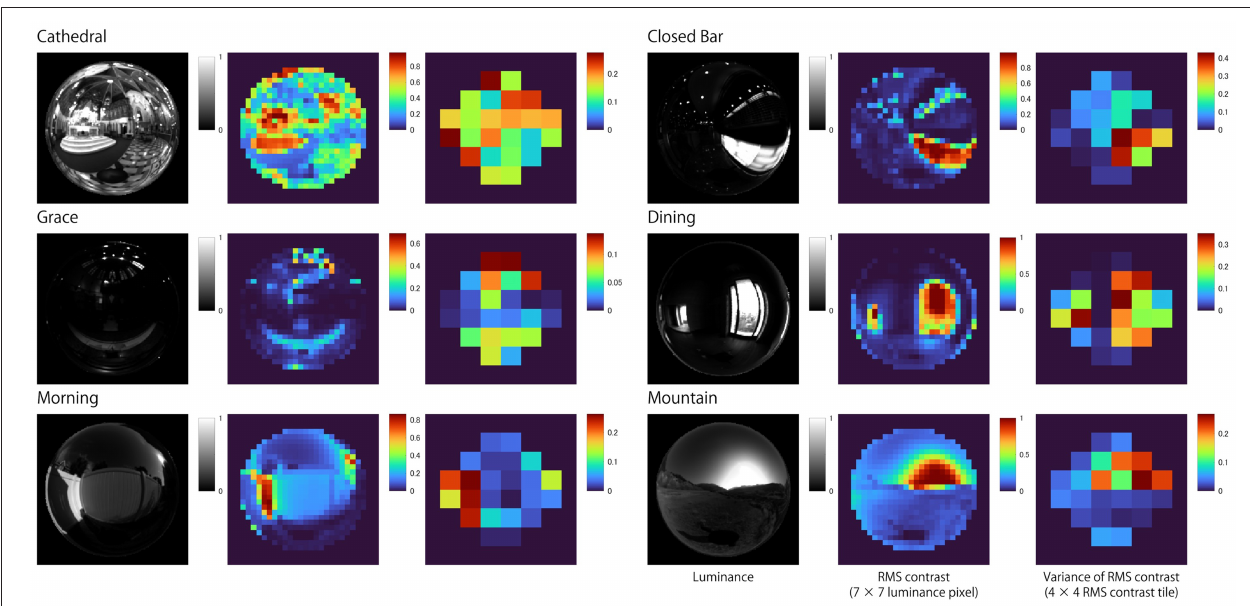
FIGURE 7 | Heatmaps showing the variance in local RMS contrast for the 100% specular surface in each of the six light fields. Note that regions of local maxima for variations in local RMS contrast generally coincide with brighter image regions.